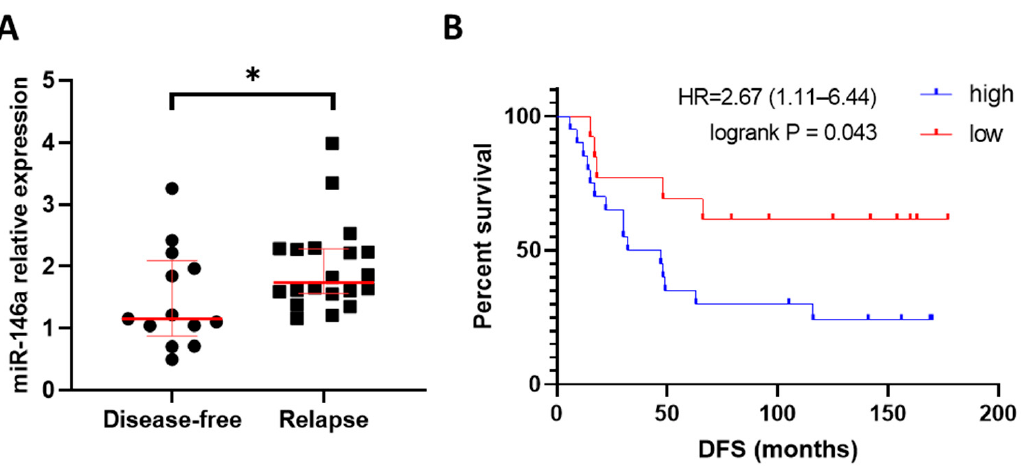
Figure 2. Analysis of the expression of miRNA-146a-5p in HER2+ breast cancer patients. ( A ) Levels of miR-146a-5p expression measured in disease-free HER2+ BC patients (n = 13) and relapsed HER2+ BC patients (n = 20) via RT-qPCR. miR-16a was used as endogenous miRNA. ( B ) Patients (n = 33) were classified based on median miR-146a-5p expression in tumor samples, and DFS Kaplan-Meier curve was plotted ( p -value = 0.043). * p -value < 0.05. HR: Hazard ratio; DFS: Disease-free survival.